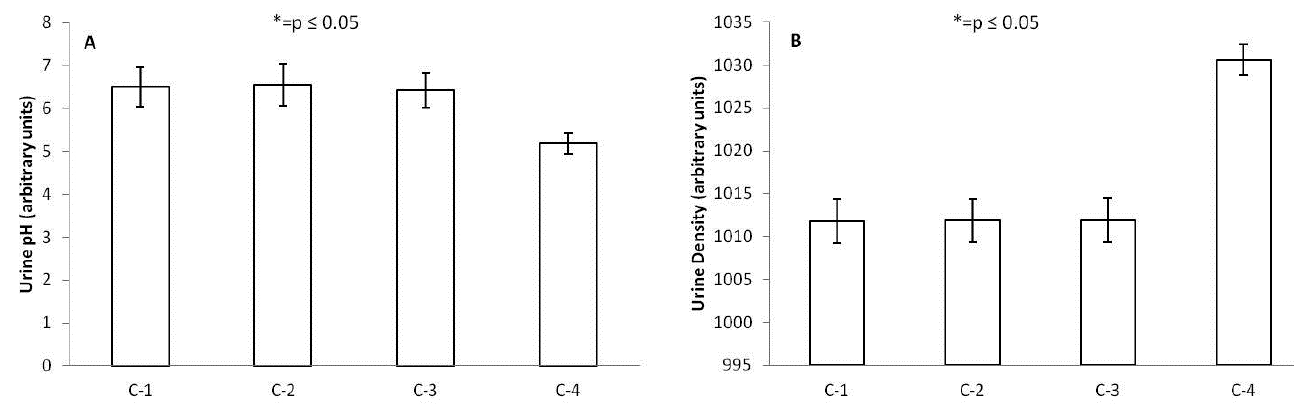
Figure 1. Urine pH in arbitrary units (1A) and urine density in arbitrary units (1B) before (C-1), during the training program (C-2), before (C-3) and after the competition (C-4). * = p <